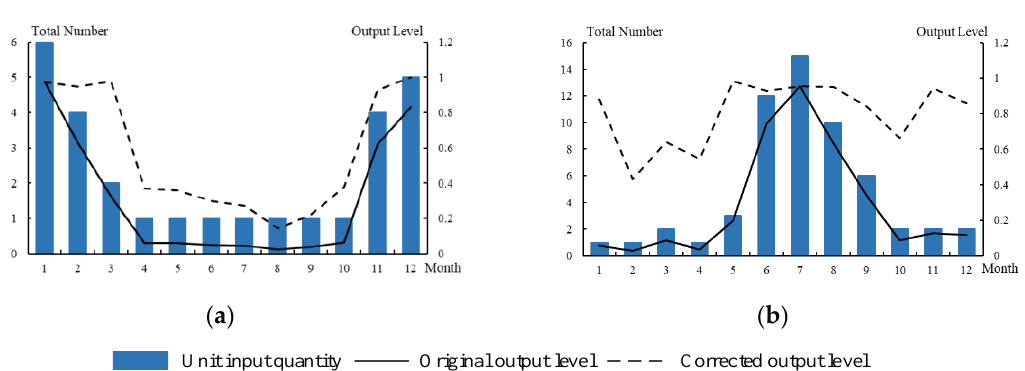
Figure 16. Device output level and unit adjustment: ( a ) electric-heat pump; ( b ) electric refrigerator.